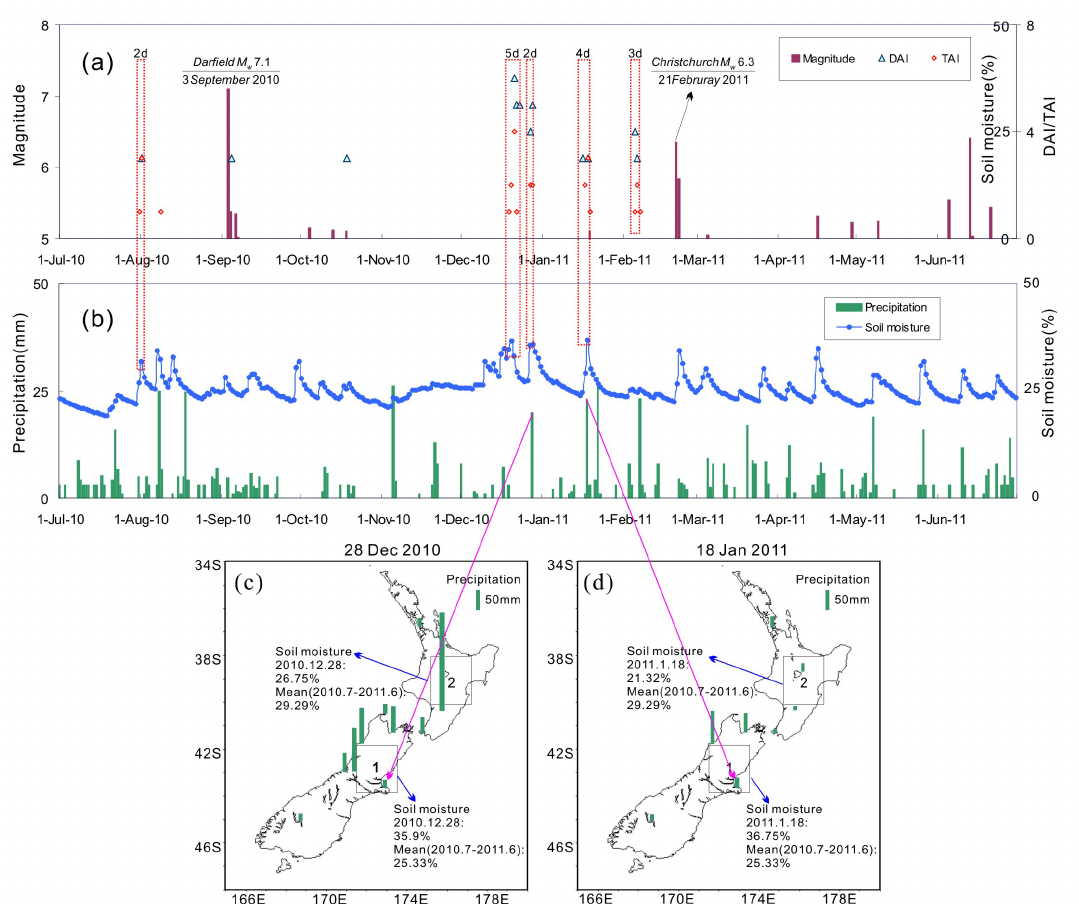
Fig. 8. (a) and (b) show the temporal quasi-synchronism of multi-parameter anomalies. The first window (2 days: 31 July and 1 Aug- sut 2010) shows the quasi-synchronism before the mainshock, and the later four windows (5 days: 19–23 December 2010; 2 days: 27 and 28 December 2010; 4 days: 16–19 January 2011; 3 days: 5–7 February 2011) show the quasi-synchronism before the 21 February 2011 aftershock. Displacement anomaly index (DAI) was obtained by adding the number of outliers of GPS simple-point displacement (only the day that had more than three outliers was shown). Thermal anomaly index (TAI) was obtained by adding the number of outliers in time series and anomalies in spatial distribution images together, both in temperature and in SLHF. The brown columns indicate the mainshock and after- shocks ( M > 5). Soil moisture has a volumetric soil water content at depth 0–10cm. Precipitation is from the weather station NZCH. (c) and (d) show that the local increment of soil moisture on the epicenter pixel in contrast to the decrement of soil moisture on the comparative pixel, on 28 December 2010 and 18 January 2011, and was likely related to the NZ earthquakes rather than regional